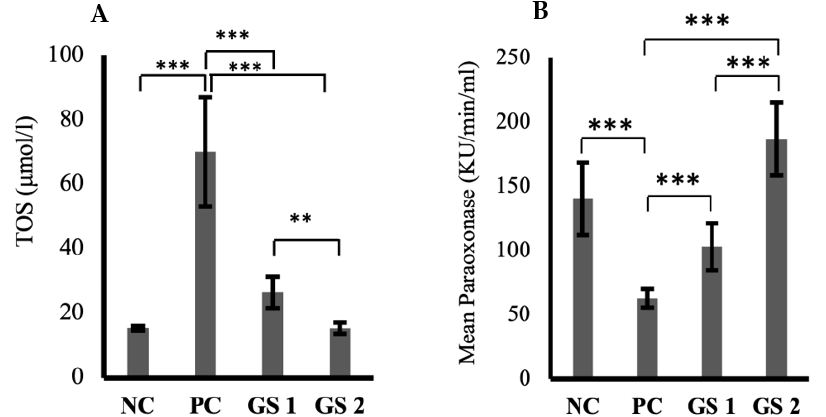
Figure 2. Mean values of total oxidant status (TOS, µmol/l) ( A ) and paraoxonase activity (KU/min/mL) ( B ) in different treatment groups. Negative control (NC), positive control (PC), Gymnema sylvestre 250 mg (GS1), Gymnema sylvestre 500 mg (GS2). ( ** ): p ≥ 0.01, ( *** ): p ≥ 0.001.